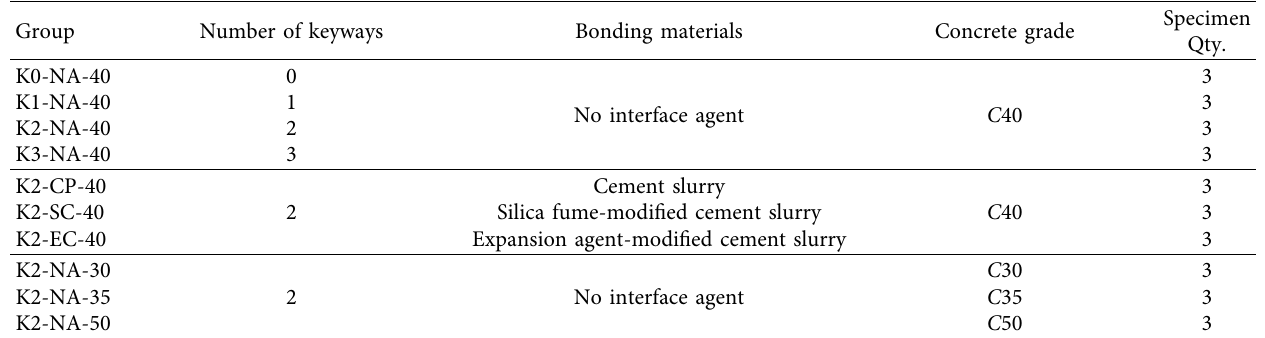
Figure 1: Dimensions of the specimen and trapezoidal keyway of UHPC-NC (unit: mm). Table 1: Parameters of specimens.